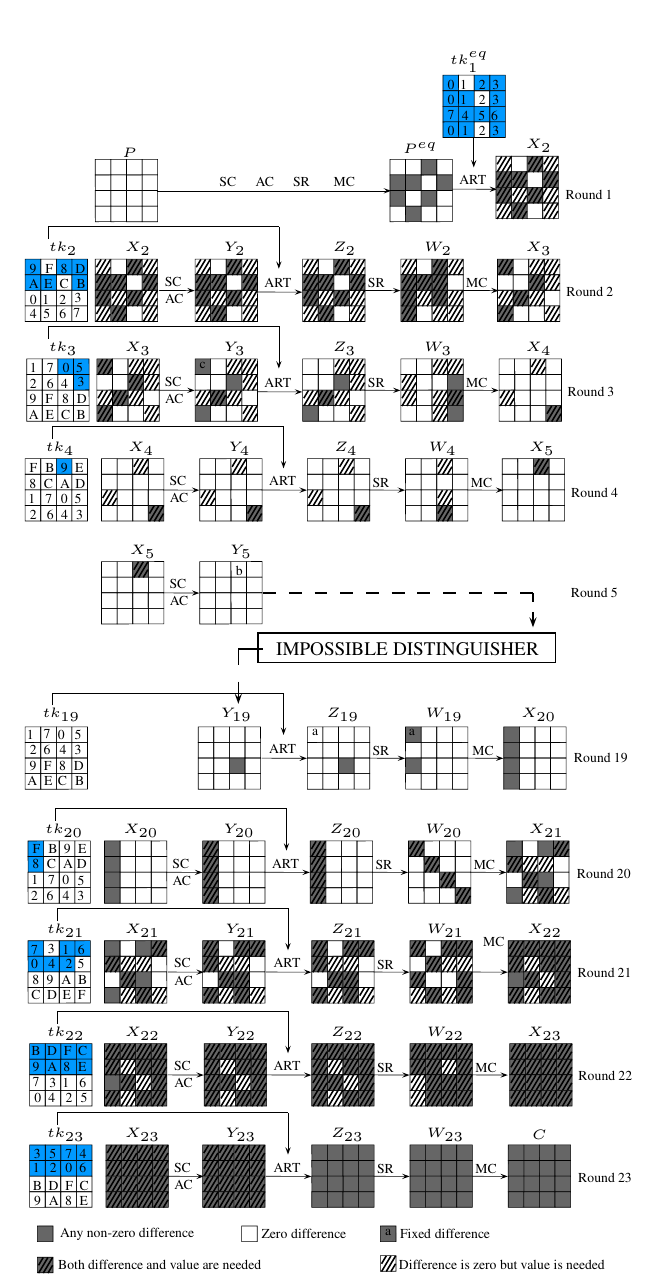
Figure 6: 23-round attack against SKINNY- n -2 n . The colored cells in each round tweakeys represent the cells, the values for which should be known to verify the differential path. During our attack, some of these tweakey cells are guessed and some of them are derived from the information that we have at each step of the